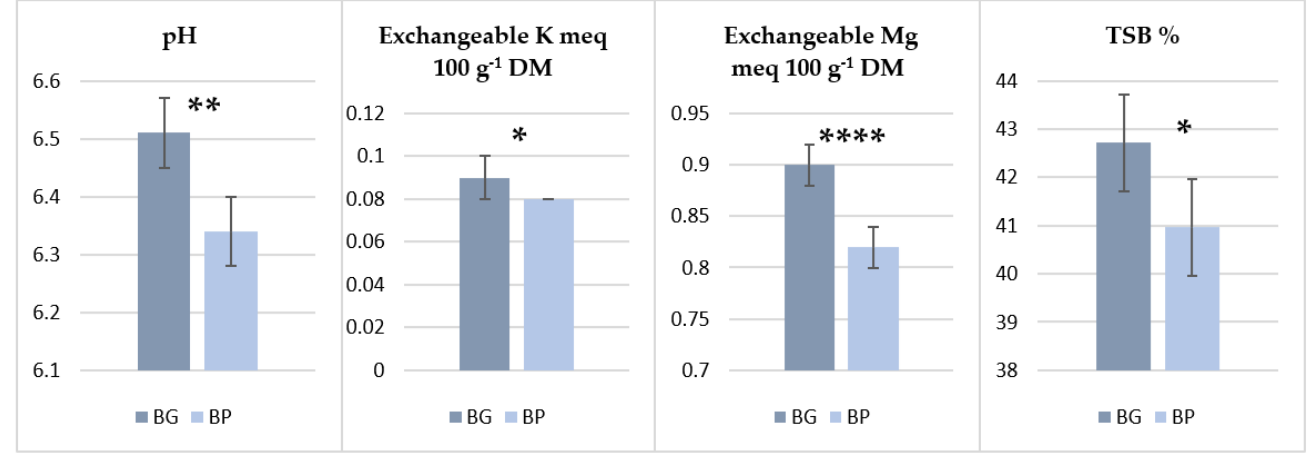
Figure 4. Effect of the biochar type on soil chemical parameters pH, exchangeable K and Mg and TSB after maize harvesting 2019. significant at: * 0.05 level; ** 0.01 level; **** 0.001 level. Table 6. Effect of biochar and fertilization on soil C org , C-to-N ratio and CEC; mean values and SE; ANOVA